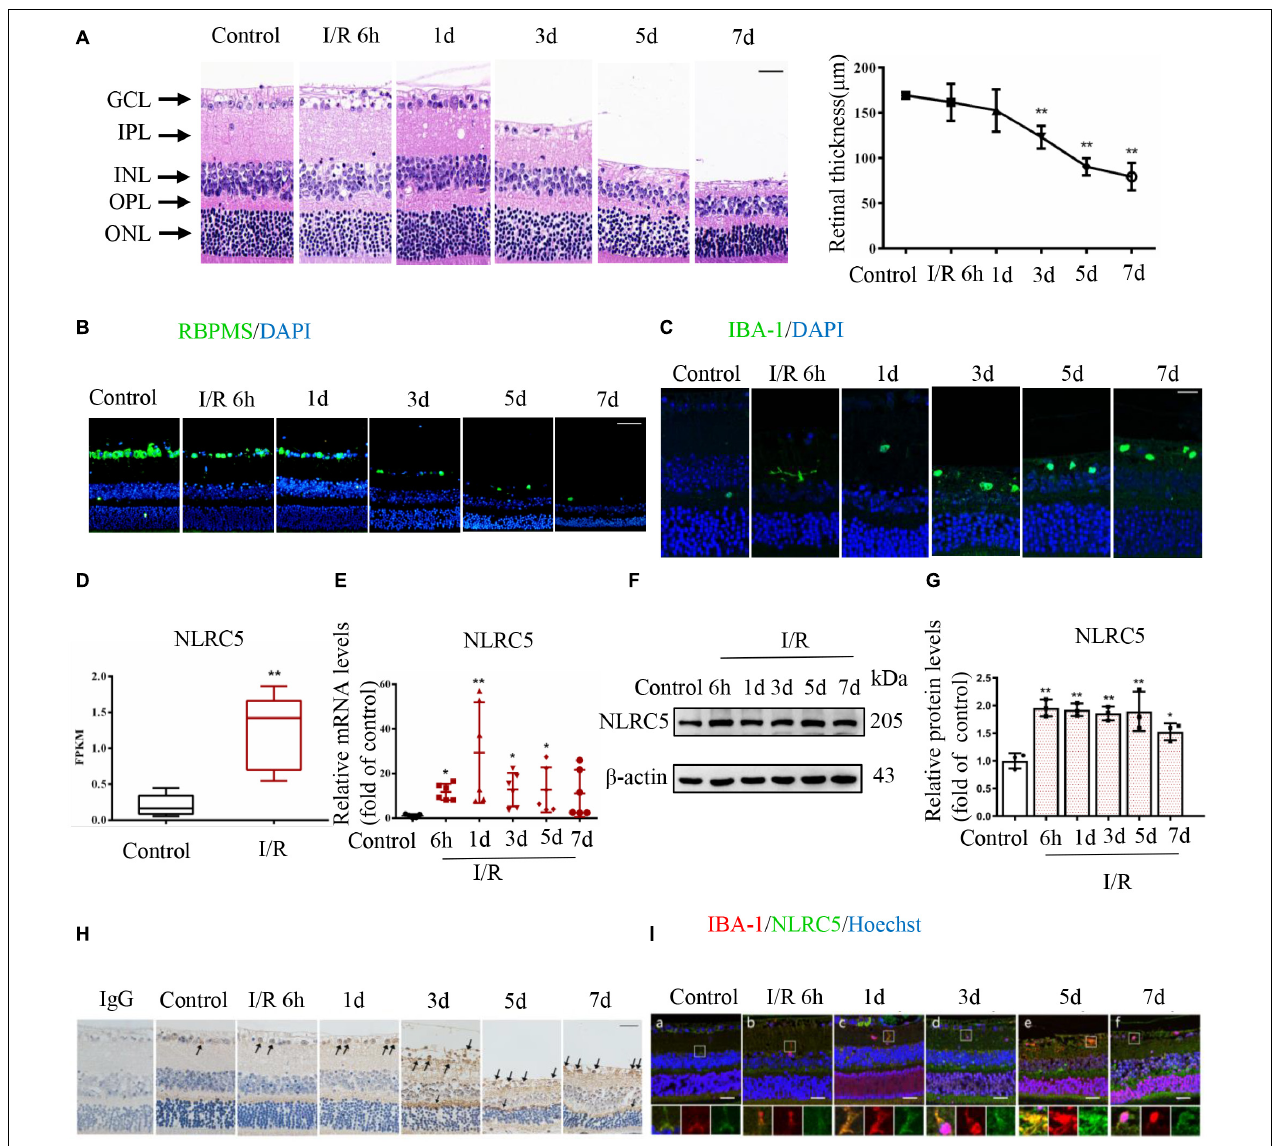
FIGURE 1 | The regulatory NOD-like receptor NLRC5 is upregulated during elevated intraocular pressure (IOP)-induced retinal ischemia–reperfusion (RIR) injury. (A) Hematoxylin and eosin (HE) staining of retinal sections showing the evolution of tissue and cellular damage during reperfusion and corresponding quantitative analysis demonstrating progressively reduced retinal thickness between the inner and outer limiting membranes (Scale bar: 30 µ m, Magnification: × 400, n = 5). (B,C) Immunofluorescence images showing reduced numbers of anti-RBPMS-labeled retinal ganglion cells (RGCs) (Scale bar: 50 µ m, Magnification: × 200) and elevated numbers of anti-Iba-1-labeled microglia (Scale bar: 15 µ m, Magnification: × 400) during RIR. (D) Box plot illustrating significantly increased NLRC5 mRNA expression in the retina of RIR injury based on RNA sequencing data from our recently published article ( n = 5). (E–G) RT-qPCR and western blot analysis showing elevated NLRC5 expression following RIR at mRNA ( n = 6) and protein levels ( n = 3), respectively. (H) Immunohistochemical analysis showing elevated NLRC5 expression during RIR (Scale bar: 30 µ m, Magnification: × 400, n = 3). (I) Dual immunofluorescence image indicating anti-Iba-1-labeled microglia (red) and NLRC5 (green) (Scale bar: 25 µ m, Magnification: × 400). I/R, retinal ischemia–reperfusion; ONL, outer nuclear layer; OPL, outer plexiform layer; INL, inner nuclear layer; IPL, inner plexiform layer; GCL, ganglion cell layer. Results (A,D,E,G) are presented as mean ± SD. * P < 0.05, ** P < 0.01. Two-tailed unpaired Student’s t -test and one-way ANOVA with post hoc Bonferroni tests was